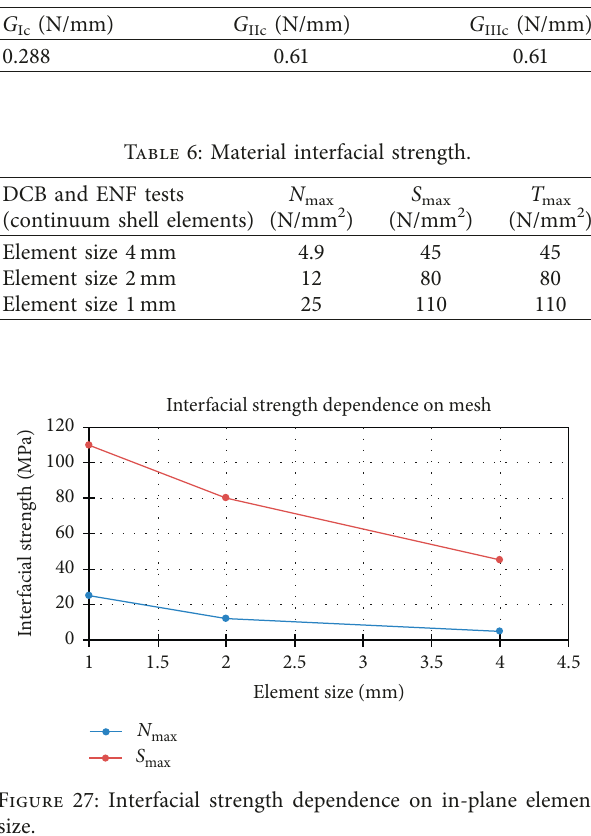
Table 5: Material fracture toughness.